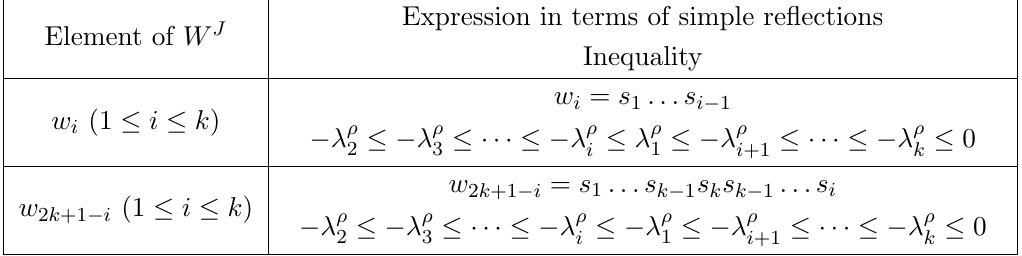
Table 6 . We write the inequality satis(cid:12)ed by a weight of the form (cid:21) = w (cid:14) ;J w i (cid:1) (cid:22) (cid:21) with (cid:22) (cid:21) antidom- inant. We recall that (cid:21) in B k is antidominant if and only if (cid:21) (cid:26) There are k 2 positive roots: k short roots of the form (cid:11) = e and k 2 (cid:0) k long roots e weight, we saw that ( (cid:21) for 2 (cid:20) i < j (cid:20) k and e